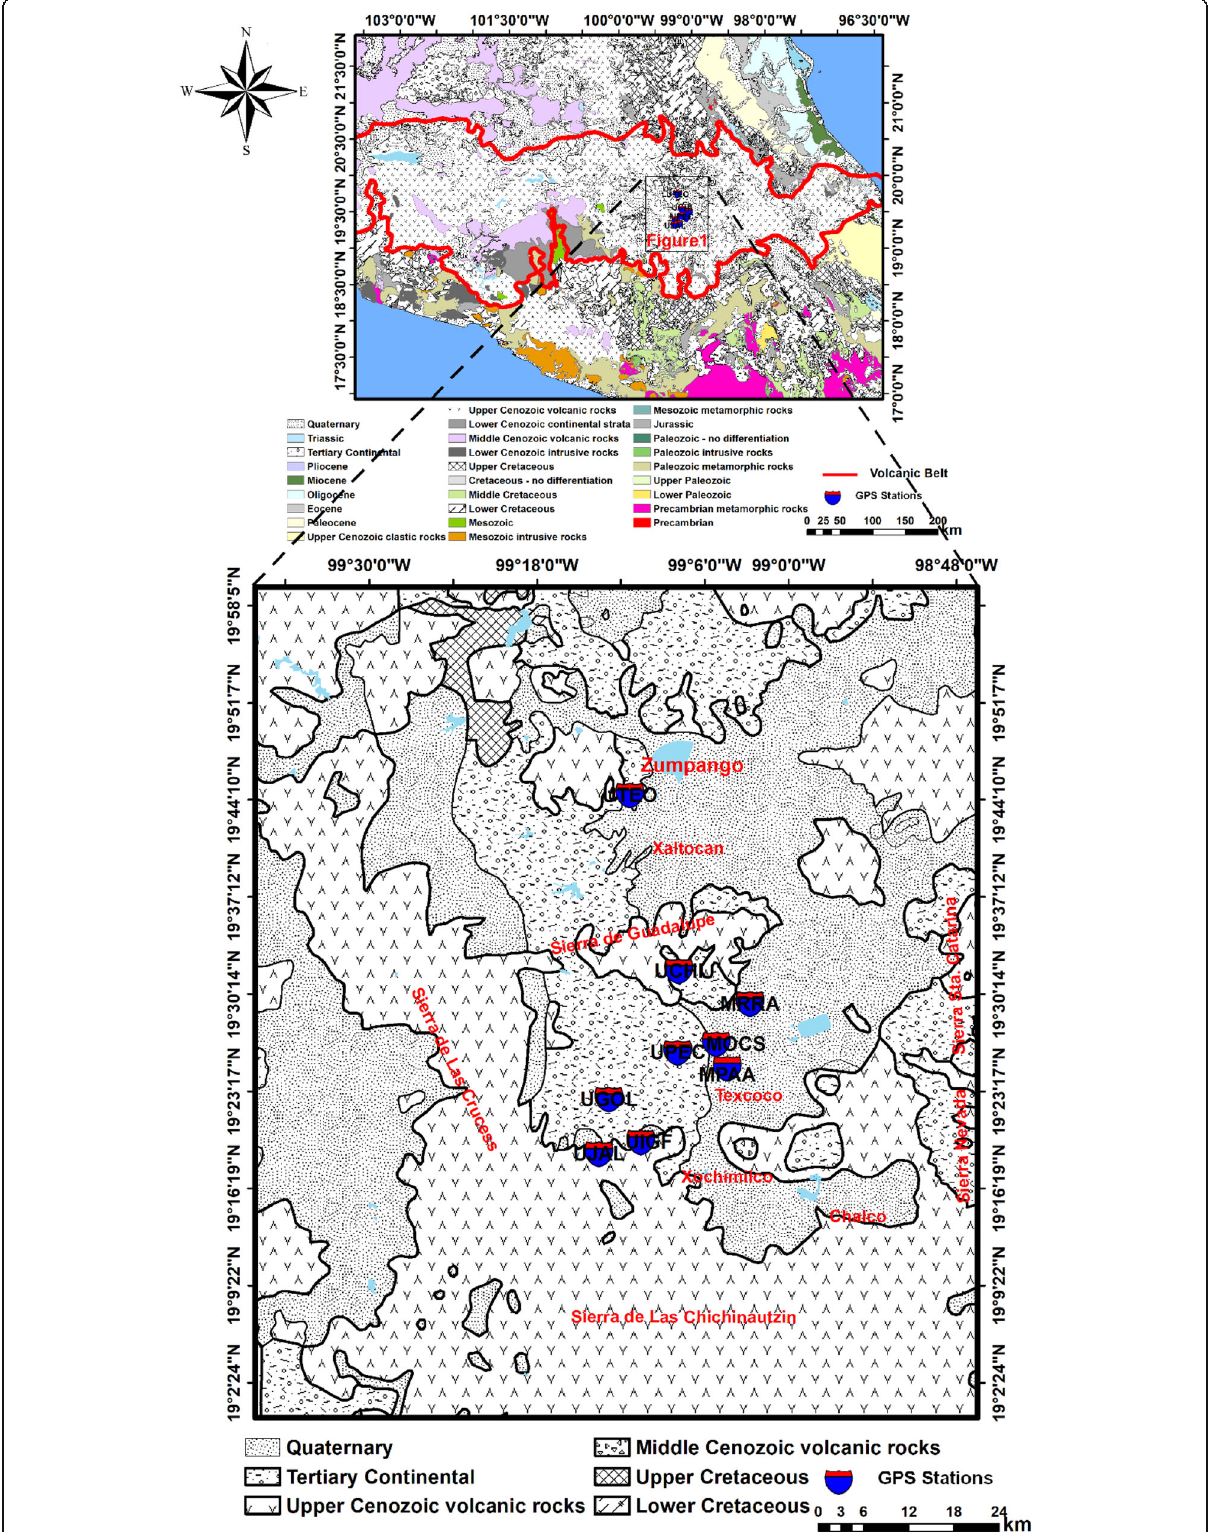
Fig. 3 Geological map of the study area showing Mexican Volcanic Belt (MVB) and other formations (black frame refers to Fig. 2 ground coverage) (Source: